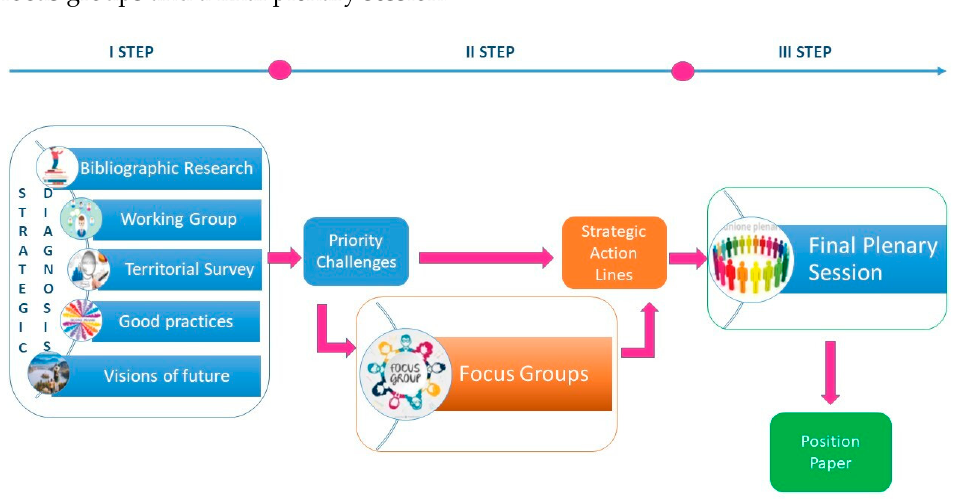
Figure 2. The implemented methodological approach for the participatory planning model.